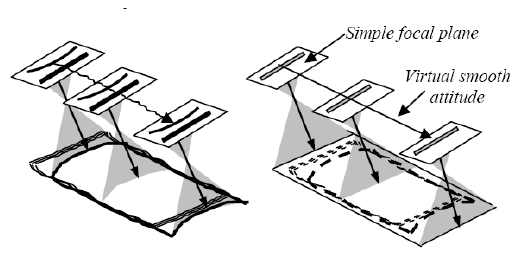
Figure 8: Perfect Sensor Geometry